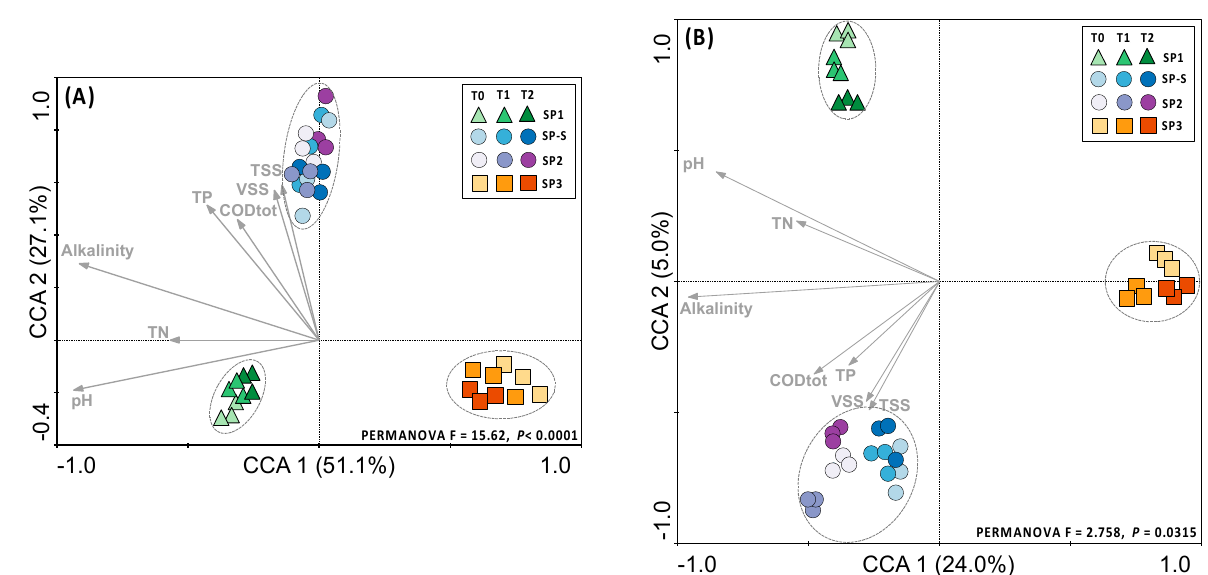
Figure 2. Canonical correspondence analysis (CCA) of the ( A ) taxonomic and ( B ) functional profiles and correlation with the physicochemical characteristics of on-site blackwater treatment. The arrows indicate the correlations between the physicochemical parameters and microbial profiles. Significant clusters (PERMANOVA, p < 0.05) are indicated by dashed lines in the graph.